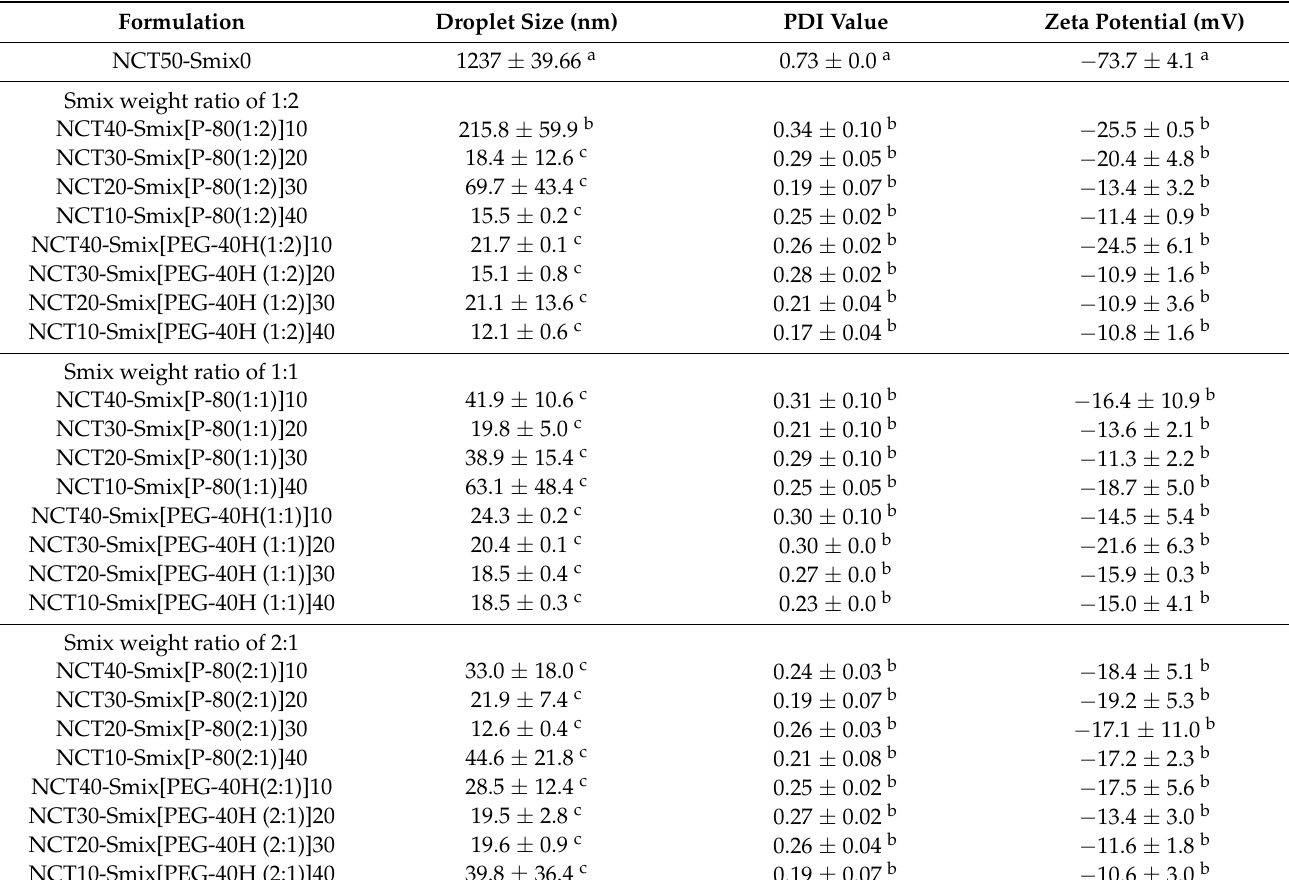
Table 1. The mean droplet size, size distribution expressed as PDI values, and zeta potential of each